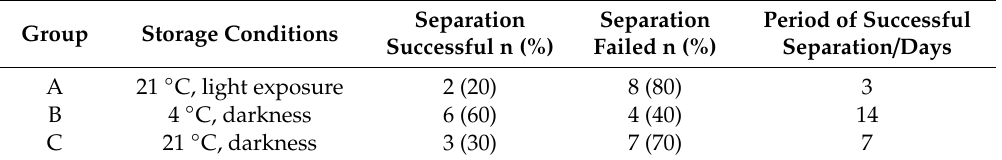
Table 3. Influence of storage conditions on the success of separation of the IPVM in unfertilized chicken eggs.